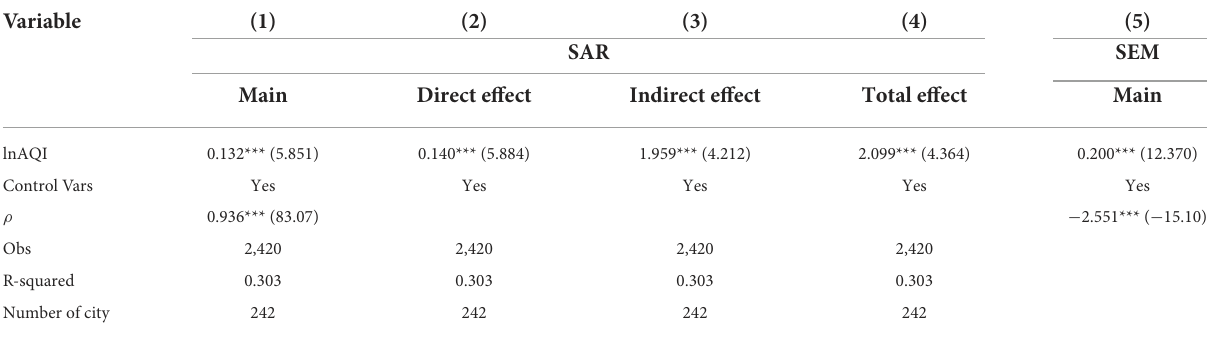
TABLE 12 SAR and SEM model regression results of air quality improvement.